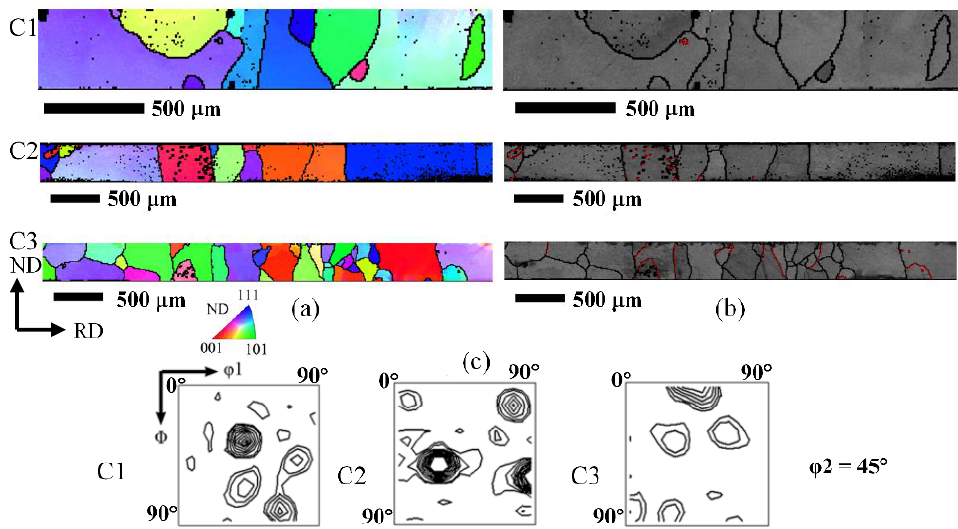
Figure 8. EBSD maps of 1# sheets similarly processed on 0.35 mm cold rolled sheets after final transformation treatment at 1150 °C under three conditions C1 to C3. ( a ) EBSD maps of IPF-ND, ( b ) Band contrast maps (red line: Σ 3); ( c ) ODFs at ϕ 2 = 45° section.